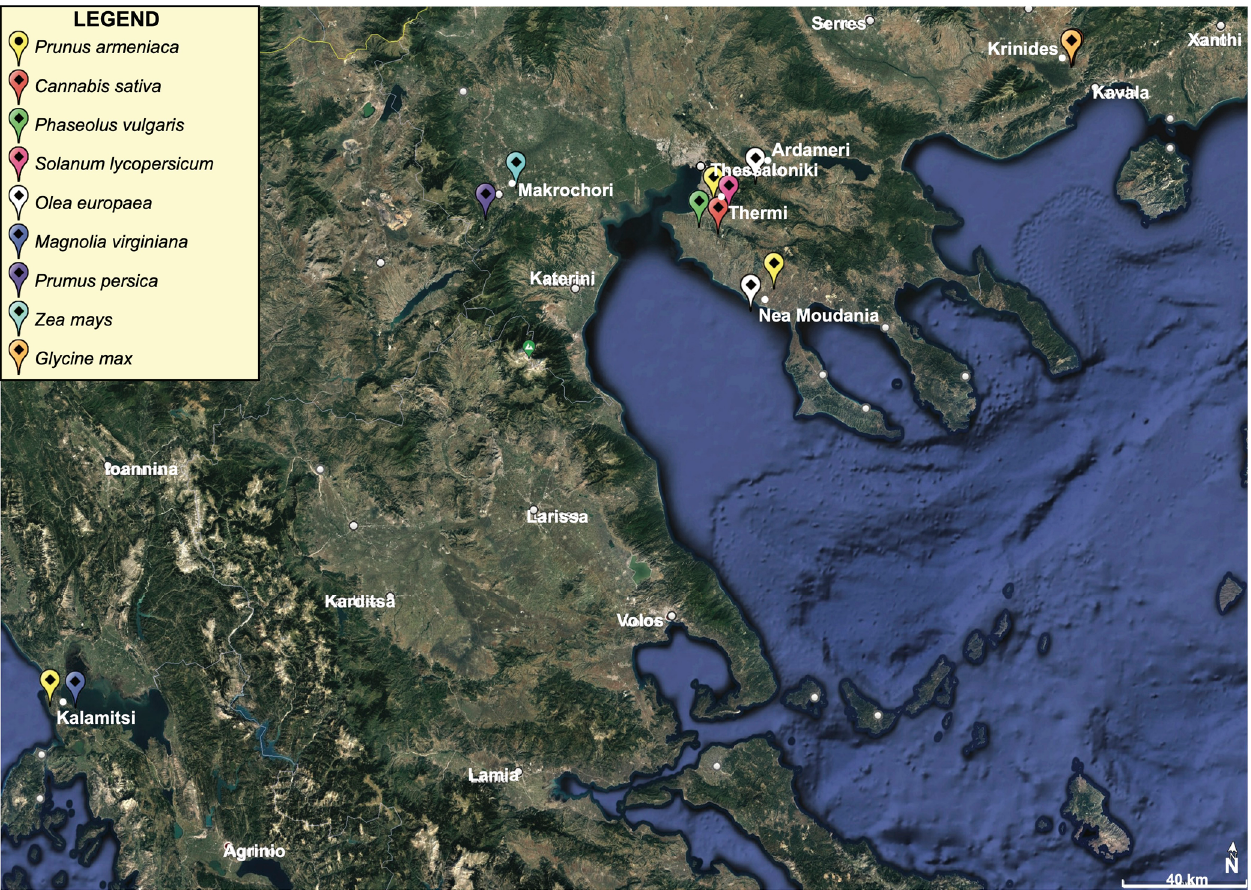
Figure 1. Satellite photo of the studied sites in Greece, coded by crop type (Google Earth © 2021 Maxar Technologies).